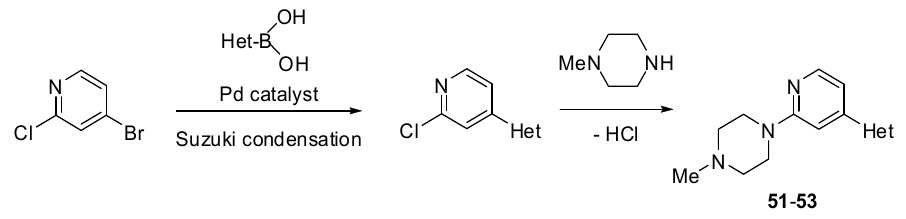
Molecules 2016 , 21 , 433